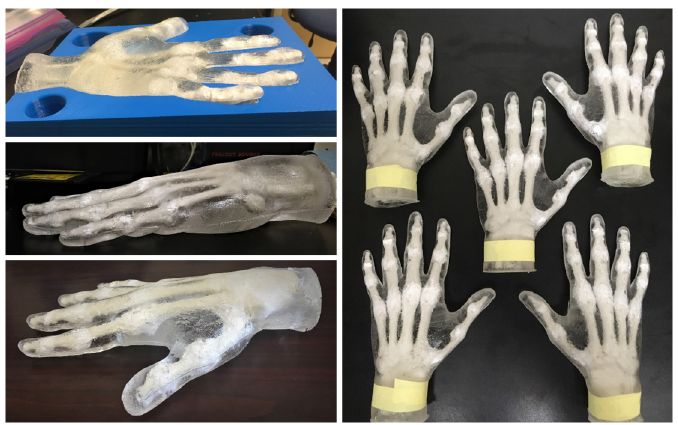
Figure 1. Lateral and top views of surrogate hand specimens described in [27].